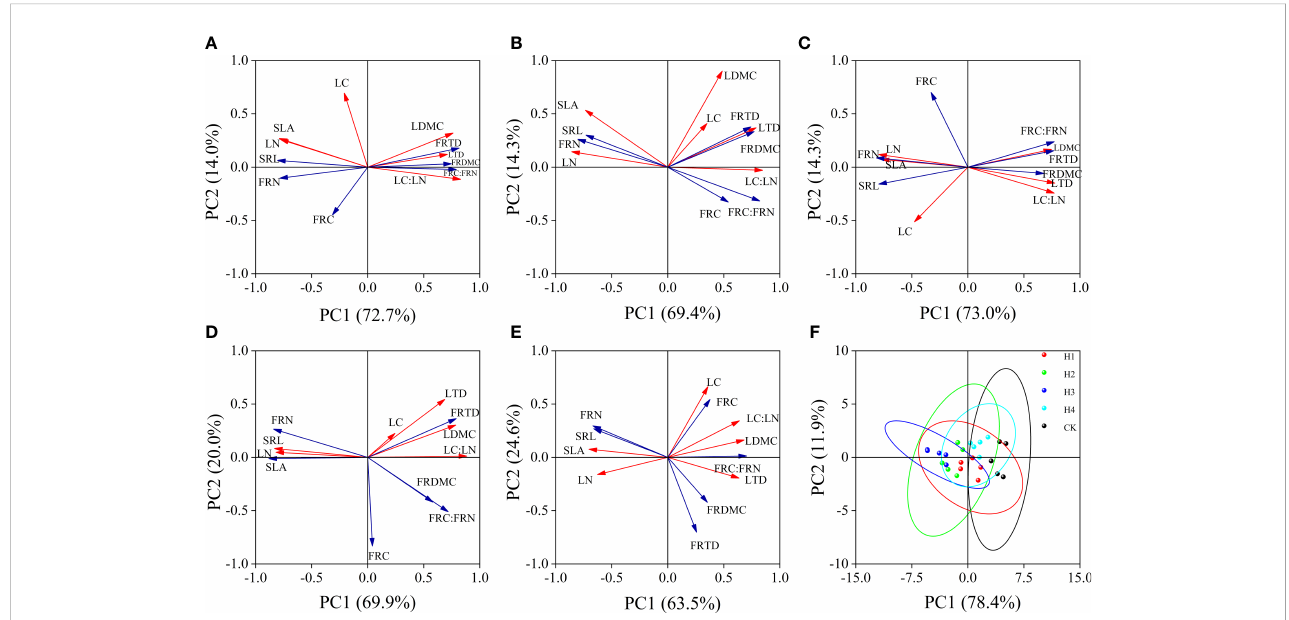
FIGURE 7 Coordination of root and leaf at different stump heights (A – E) . Principal component analysis of leaves and fi ne roots at 0, 10, 15, 20 cm and without stumps respectively. (F) is the analysis of the principal component of the leaves and fi ne roots at different stump heights. (All abbreviations are shown in Figure